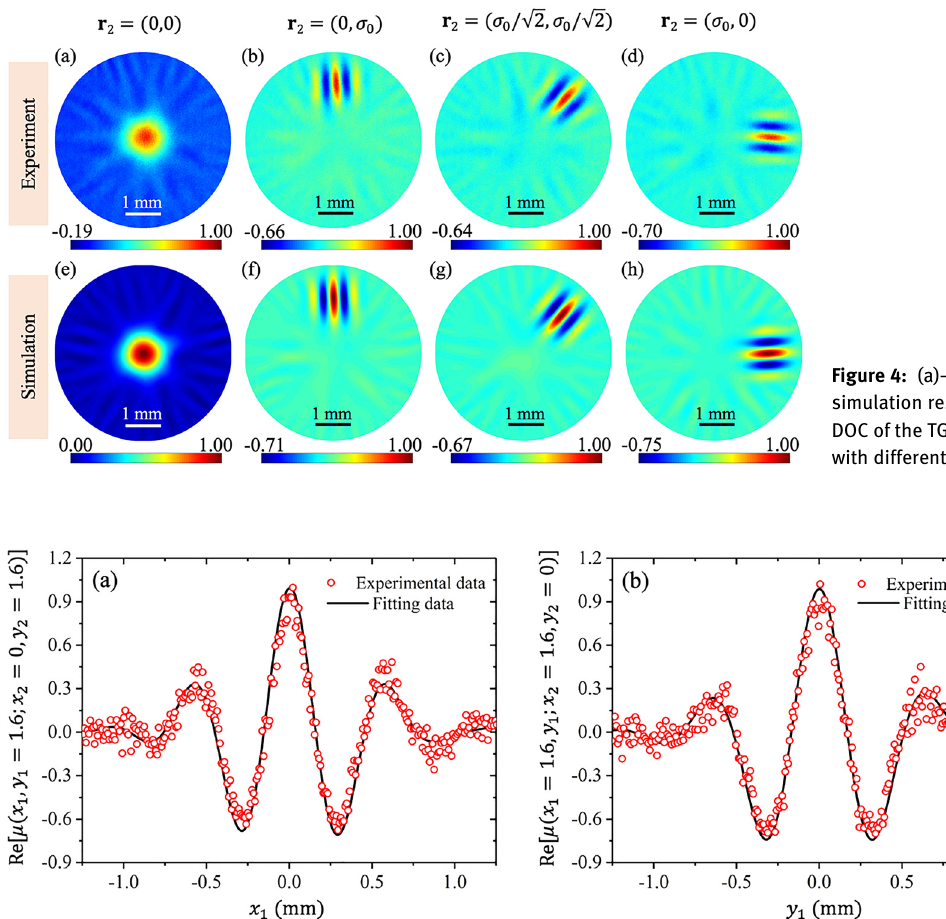
Figure5: Thecross-lineoftherealpartoftheDOCfunctionoftheTGSMbeamwhenthereferencepointsareselectedas(a) r 2 = ( 0 , σ 0 ) and(b) r 2 = ( σ 0 , 0 ) . The solid curves denote the theoretical fi ts from the experimental